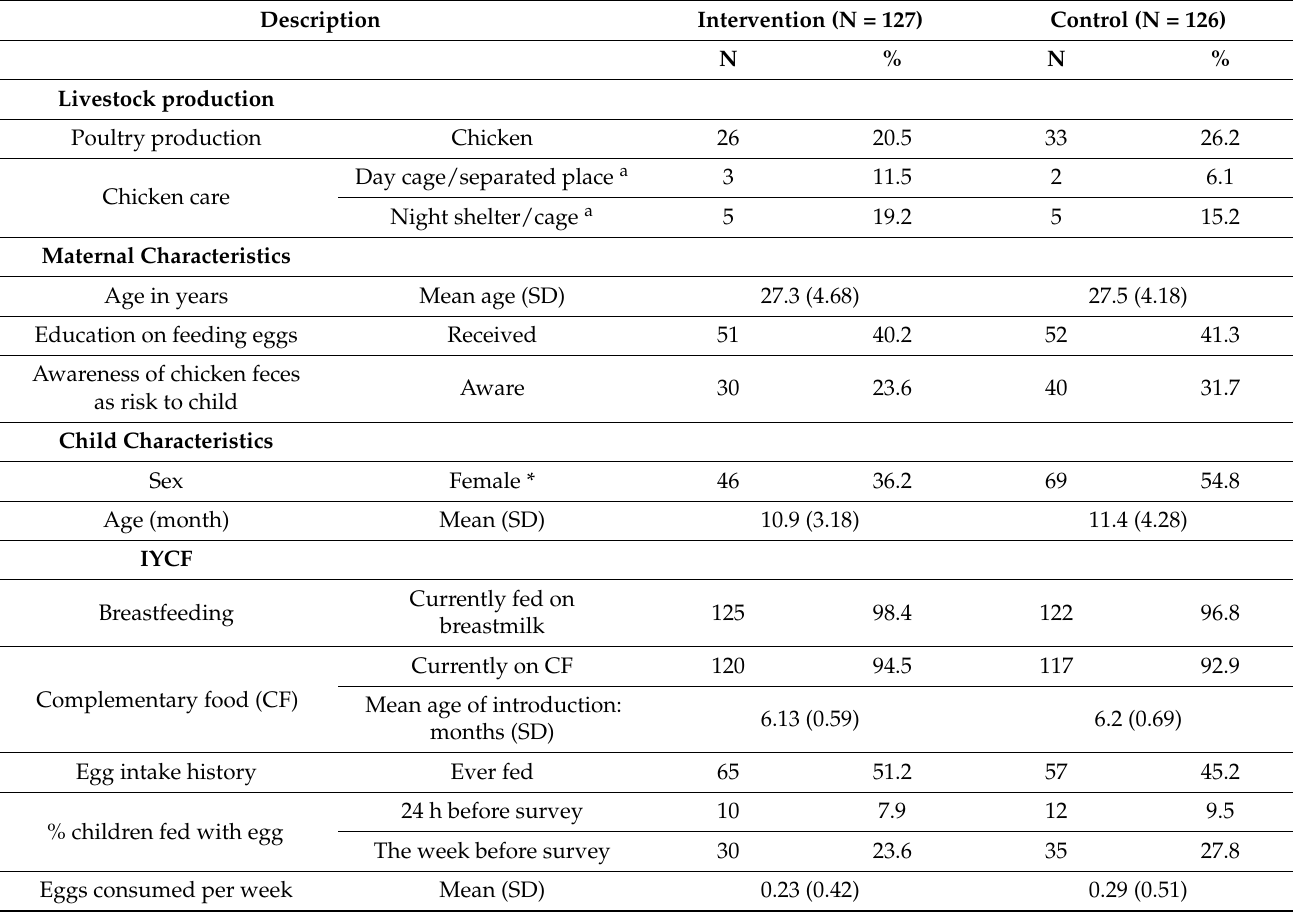
Table 1. Selected baseline characteristics and IYCF